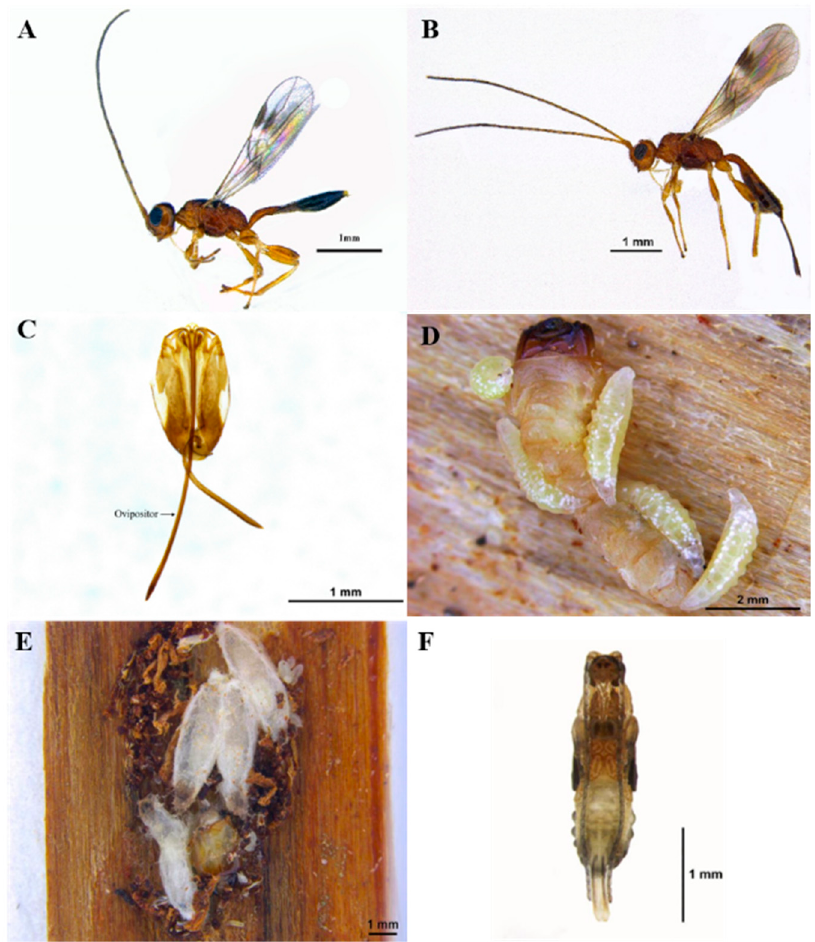
Figure 3. Spathius verustus : ( A ) male habitus, lateral view; ( B ) female habitus, lateral view; ( C ) female genitalia; ( D ) mature larvae of S. verustus on a larva of M. alternatus ; ( E ) cocoons near the dead host in the tunnel dug by the host; ( F ) Pupa, female. in the tunnel dug by the host; ( F ) Pupa,